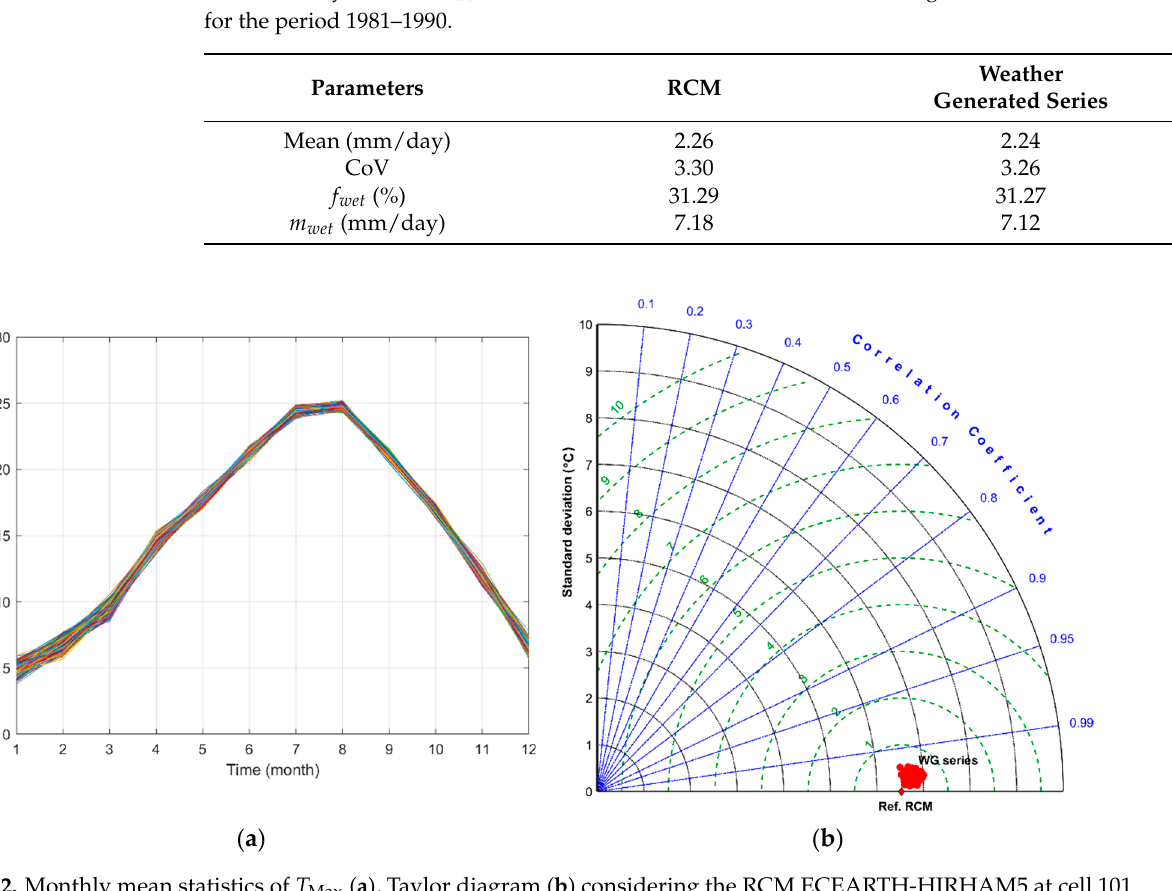
Figure 2. Monthly mean statistics of T Max ( a ), Taylor diagram ( b ) considering the RCM ECEARTH-HIRHAM5 at cell 101 and the period 1981–1990. In ( b ), each red dot represents a generated series made with the investigated model, whereas the red diamond represents the reference one.